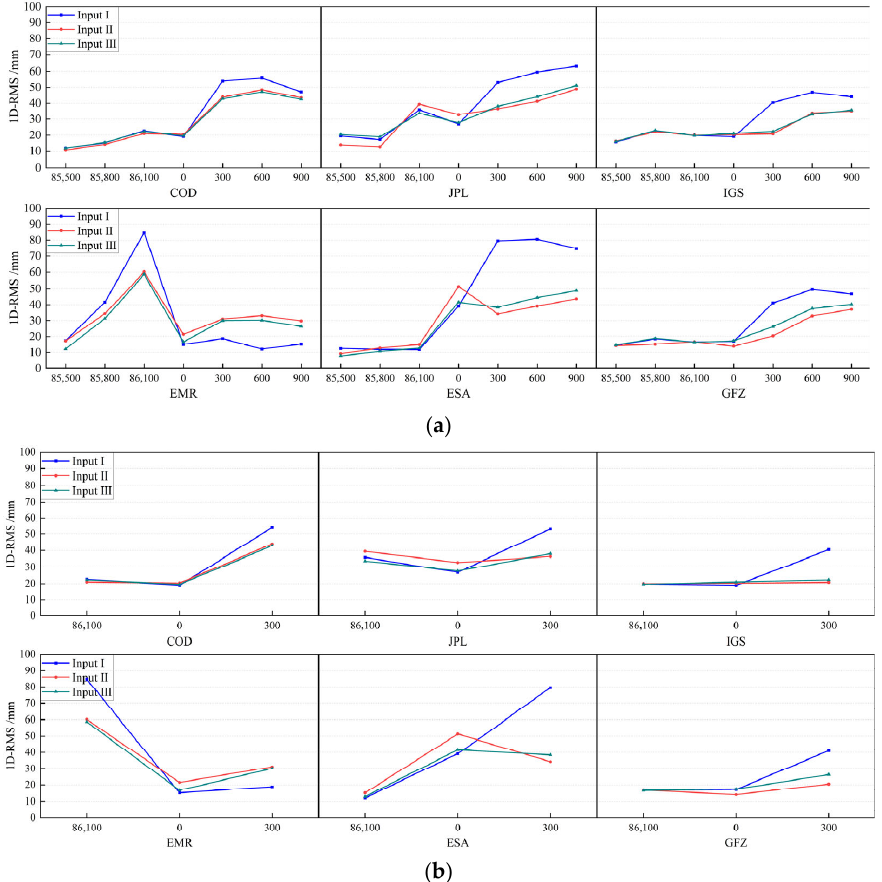
Figure 6. Time series near the daily boundary of YAKT (unit: mm). The horizontal coordinate is expressed in seconds in days and the vertical coordinate is 1D-RMS of PPP positioning. ( a ) 15 min near the day boundary ( b ) 5 min near the day boundary.